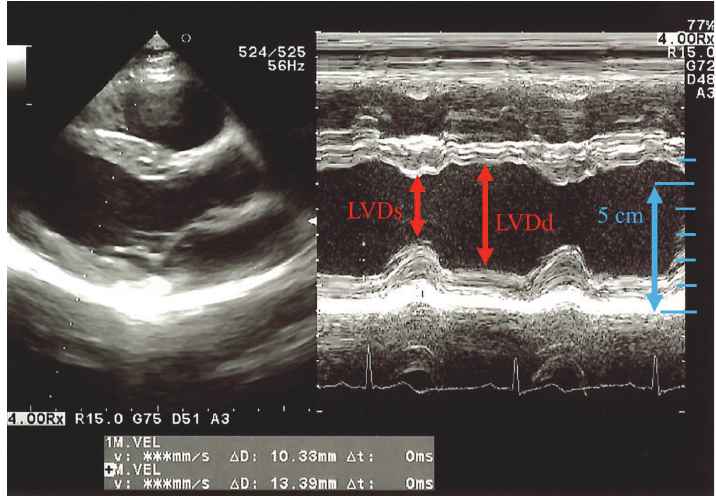
Figure 1. Ultrasonic image of left ventricle of the heart.